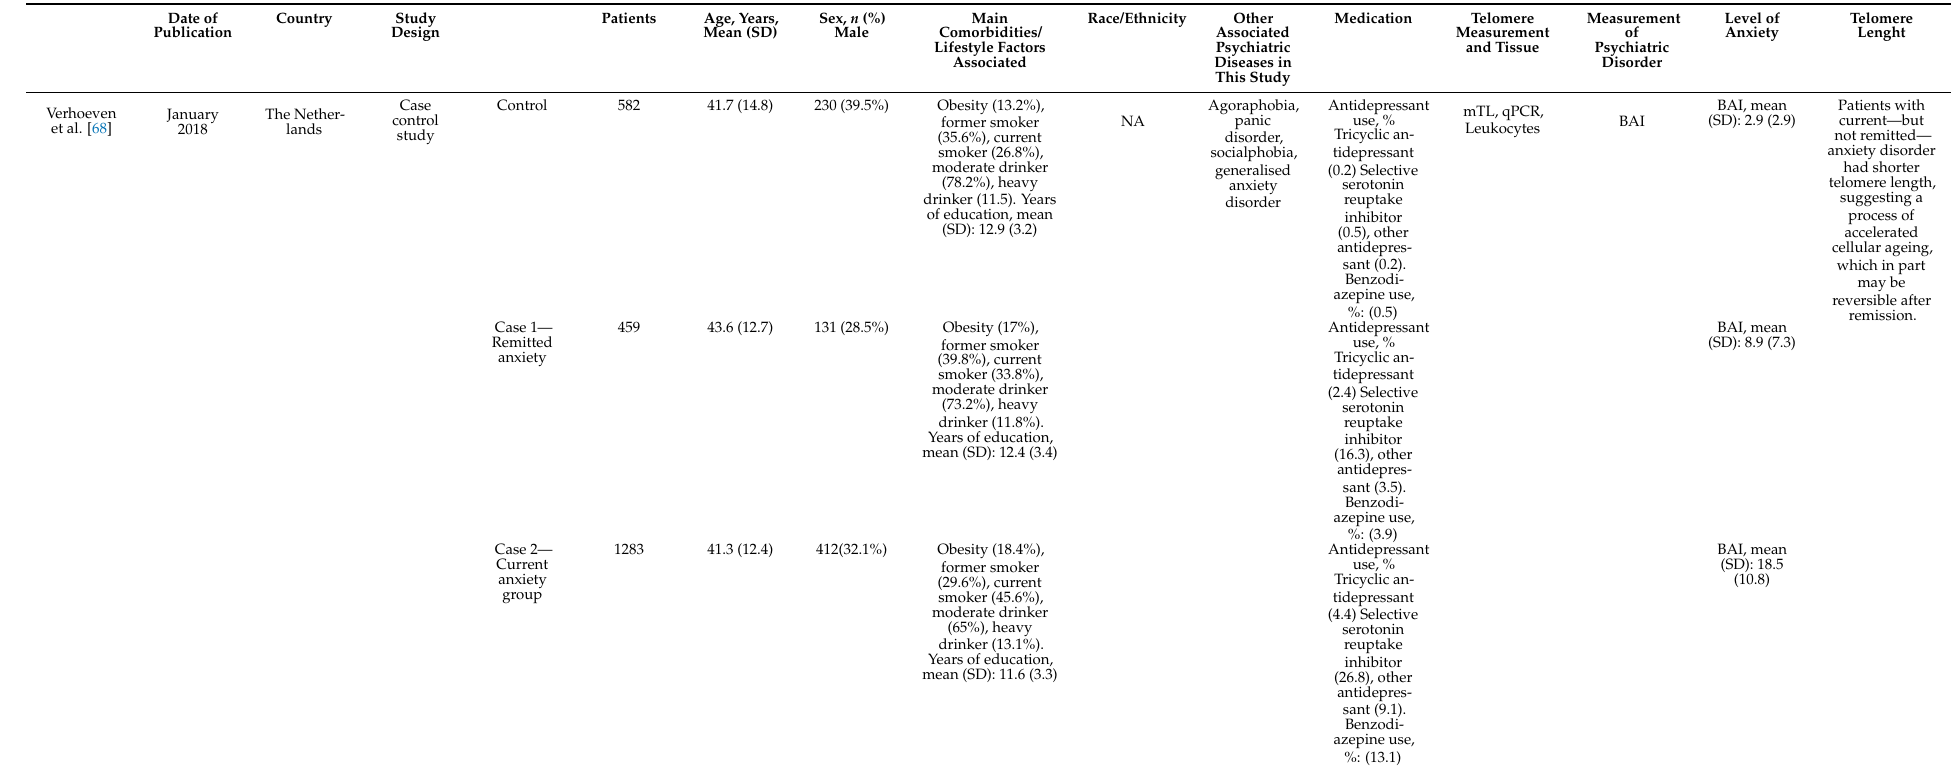
Table 3. Study characteristics, clinical and epidemiological data analysis of anxiety disorders impacts on telomere